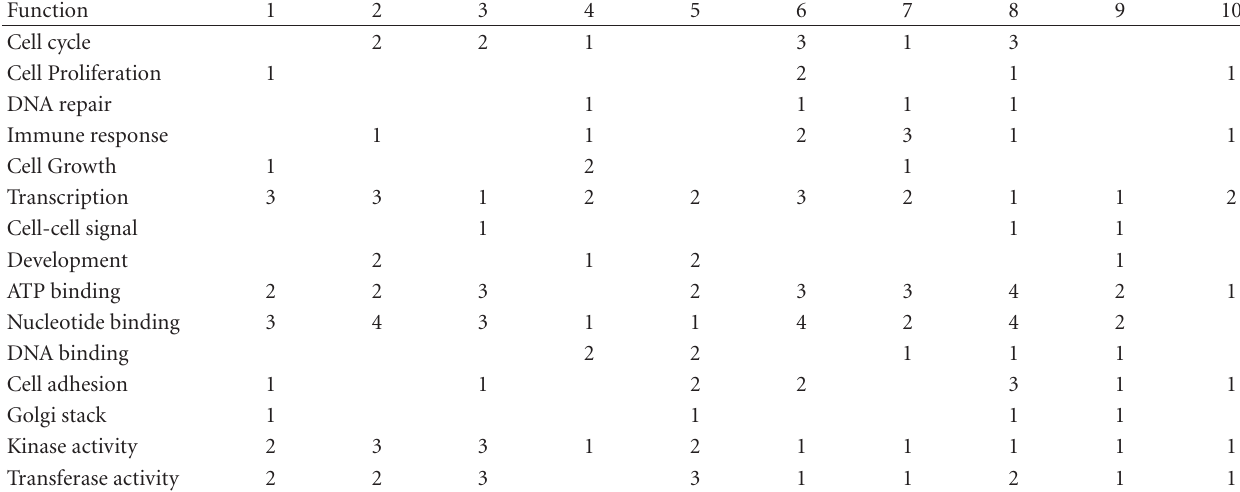
Table 1: Annotation analysis of the signatures 1 to 10; the table entries show the number of genes found in each signature to include the function shown in the first column, with a blank indicating